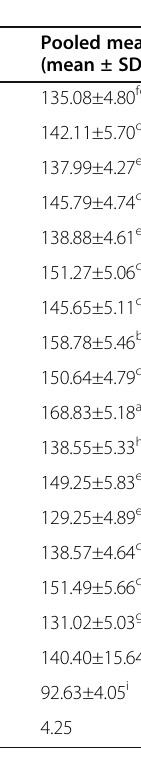
Table 5 Effect of application of Trichoderma isolates on number of fruits and yield under field conditions Isolates